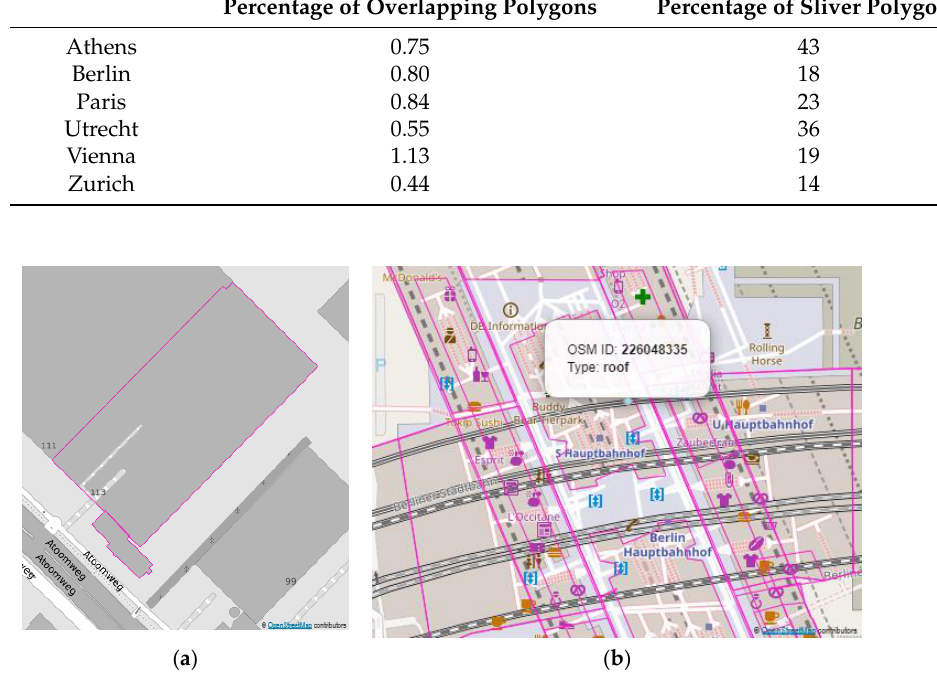
Table 4. Errors in internal topology checks for buildings.